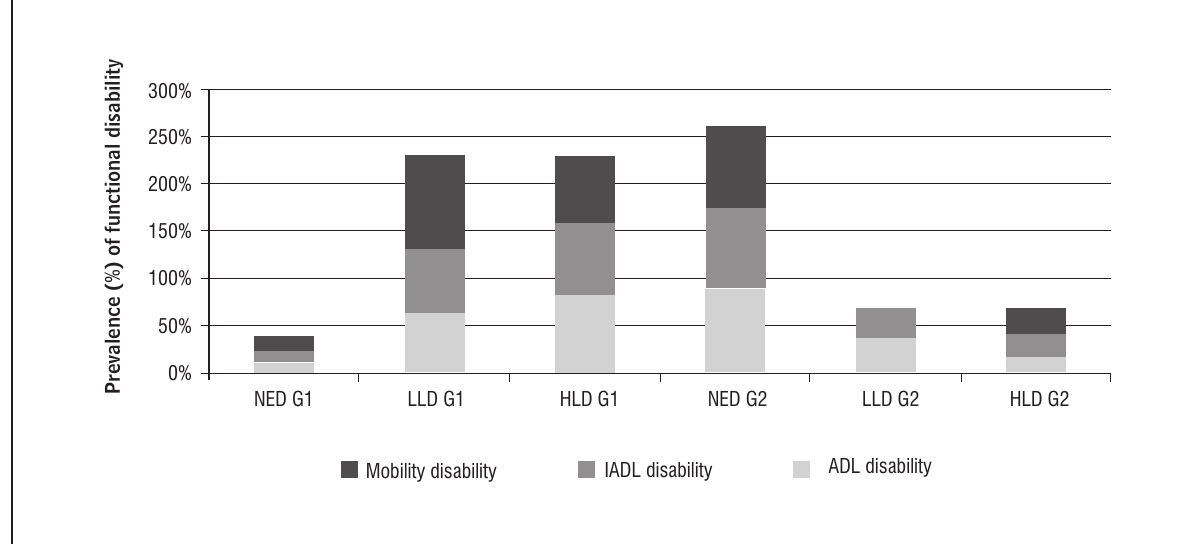
Figure 1 - Prevalence of functional disability according to the self-report of eyesight difficulties in G1 and G2 Note: NED: No eyesight dif fi culties; LLD: Low level of eyesight dif fi culty; HLD: High level of eyesight dif fi culty. Source: Research